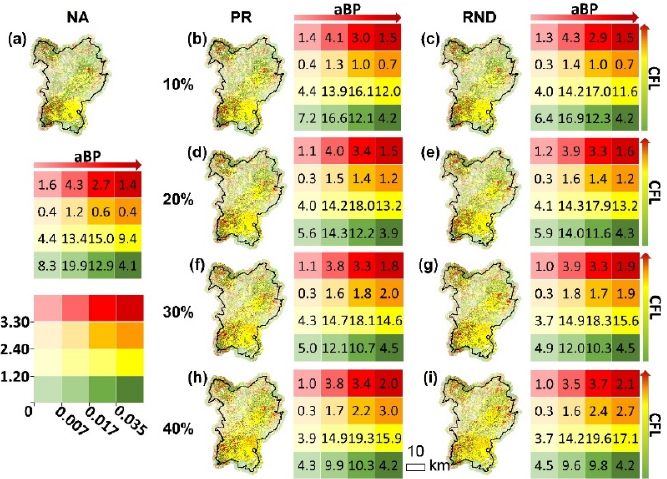
Figure 5. Combination of simulated annual burn probability (aBP) and conditional flame length (CFL, m) in the study area for the NA and two spatial patterns of land abandonment scenarios